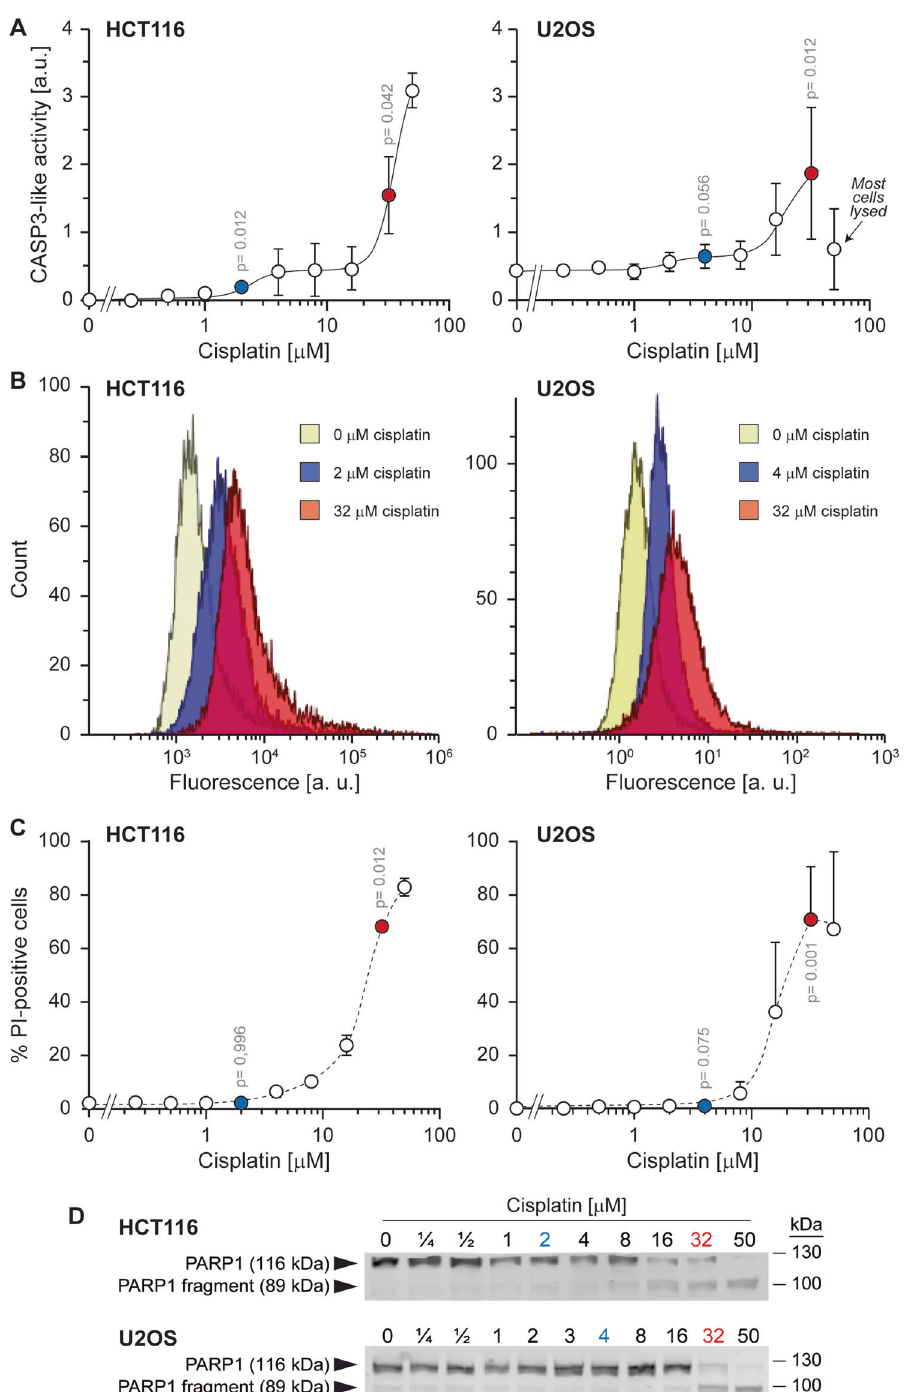
Fig. 1 Monitoring CASP3-like activity, cell death and apoptosis in HCT116 and U2OS cell lines upon treatment with increasing cisplatin concentrations. HCT116 and U2OS cells stably expressing the VC3AI CASP3-like activity sensor (120,000 cells seeded in 2 ml of DMEM supplemented with 10% heat-inactivated FBS in wells of 6-well plates) were treated for 48 h with the indicated cisplatin concentrations. A – B Fluorescence of the VC3AI sensor was recorded by fl ow cytometry. The data in panel A correspond to the mean (auto fl uorescence of the cells subtracted; see Figure S4) ±standard deviation (SD) of four independent experiments. Statistical analyses were performed using paired t - test. Panel B shows the fl ow cytometry pro fi les of cells exposed to the cisplatin concentrations highlighted in blue and red in panel A . C Cell death was recorded by fl ow cytometry following PI staining. The data correspond to the mean ± SD of four independent experiments. Statistical analyses were performed using paired t test. D PARP1 cleavage was assessed by western